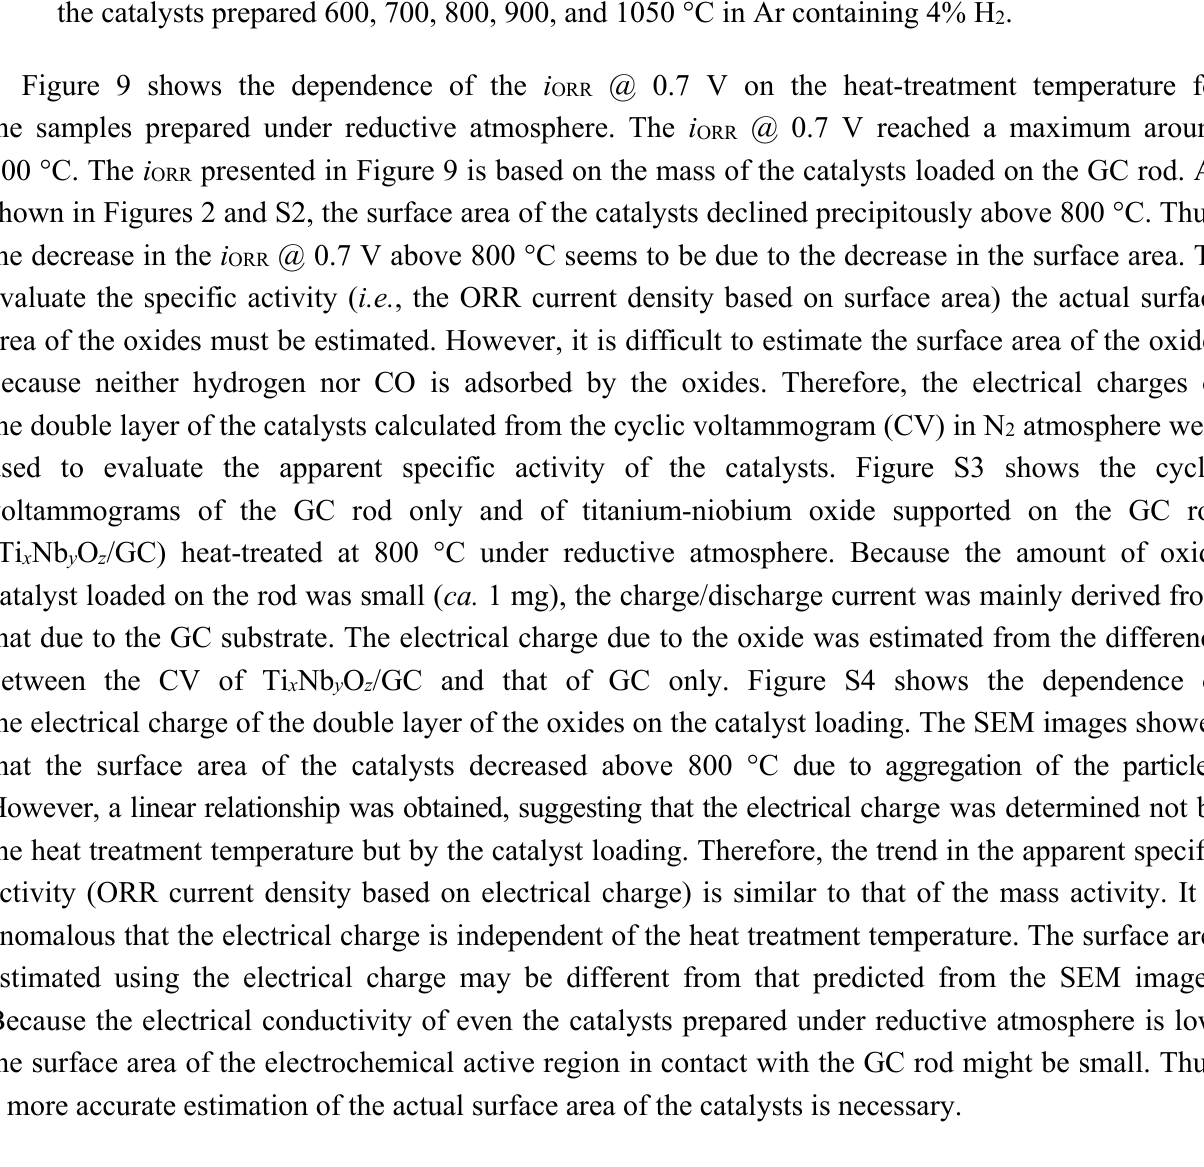
Figure 8. ( a ) Potential- i ORR curves for the catalysts prepared 600, 700, and 1050 °C in Ar containing 4% H 2 and ( b ) potential- i ORR curves in the higher potential region